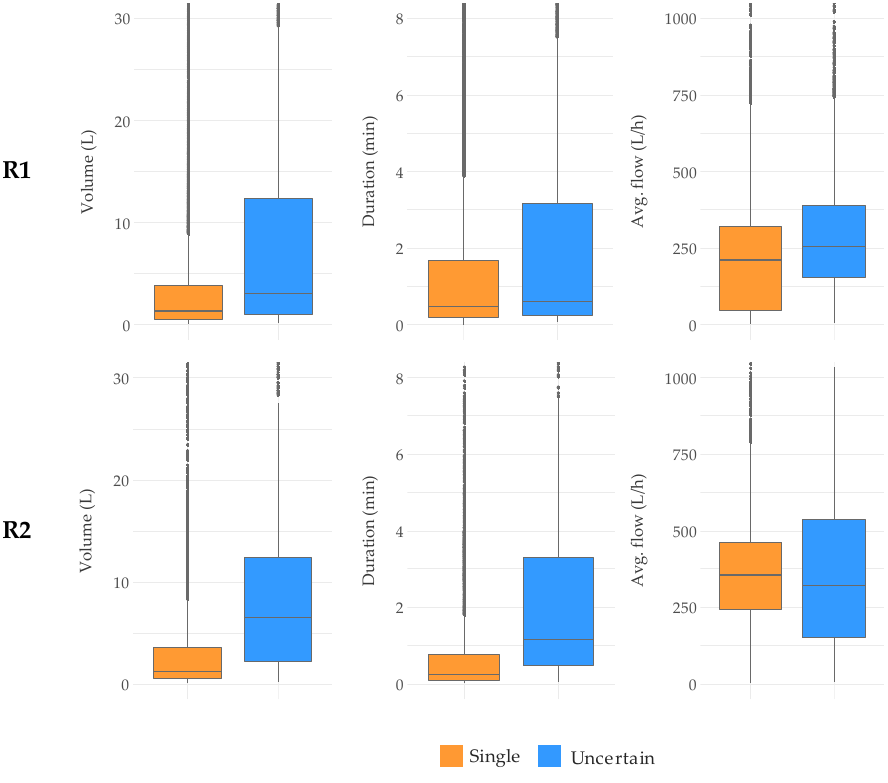
Figure 9. Distribution of the physical characteristics of the events classified as single-use and uncertain per study.